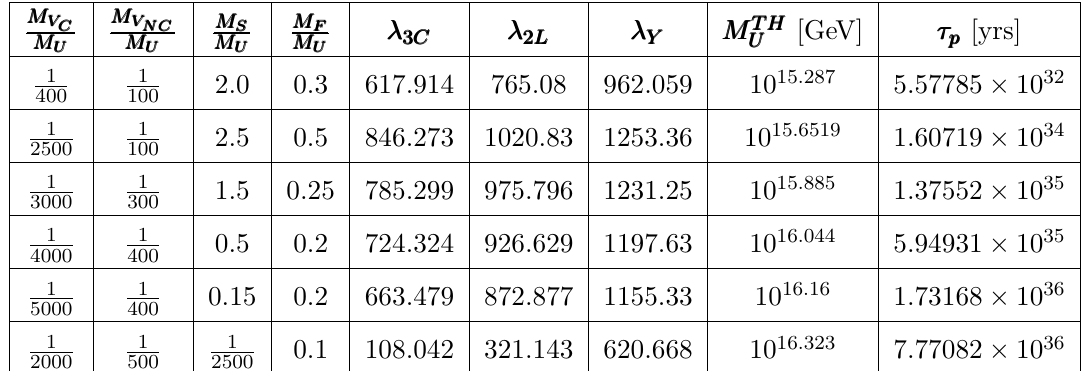
Table 5 . Numerically estimated values of M U and τ p by including one-loop threshold effects by considering non-degenerate masses for super heavy vector bosons.